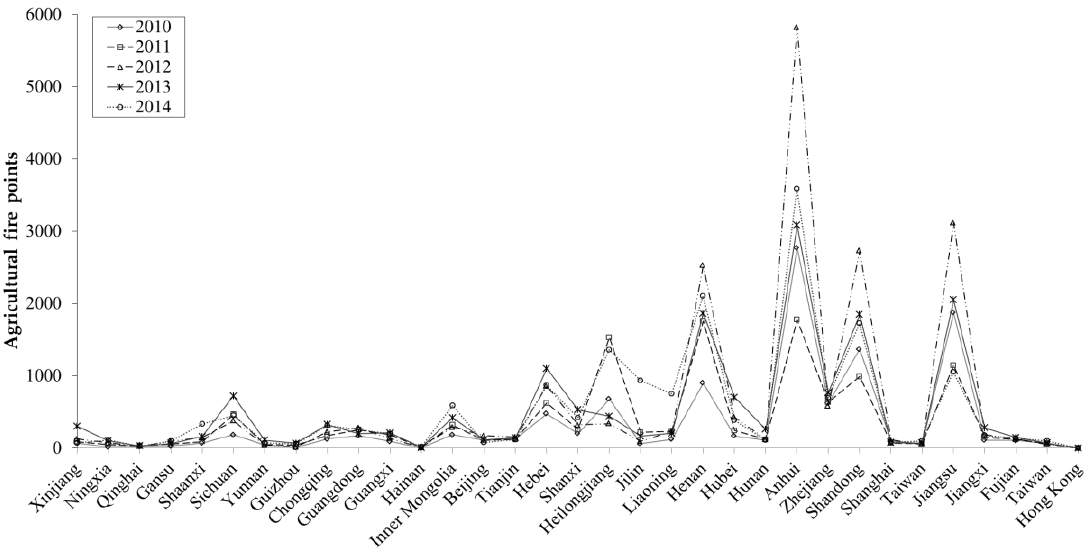
Figure 9. Spatial distribution of agricultural fires at a provincial level from 2010 to 2014.